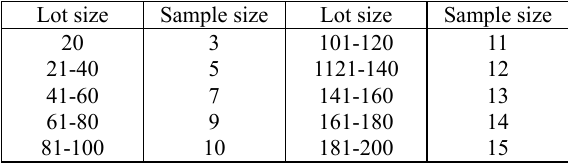
Table 2. Lot size and sample size